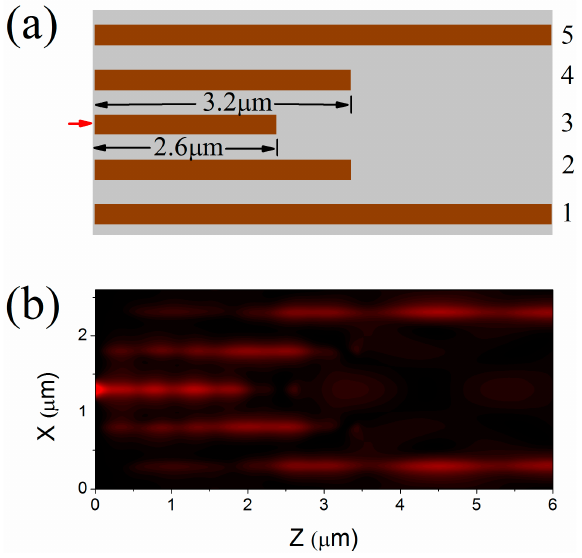
Figure 6. ( a ) Schemes of 1 × 2 power splitter based on five HPWs. ( b ) The intensity distribution of SPPs in the power splitter.